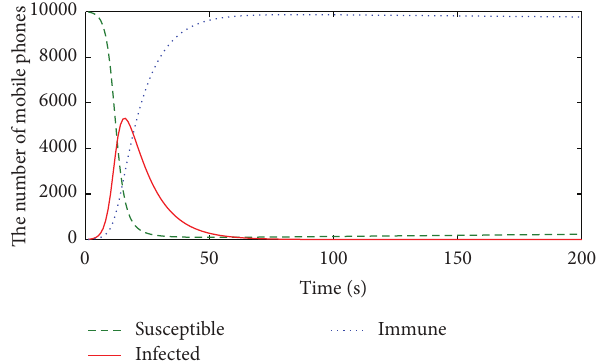
rapid the propagation speed and wide the propagation scope of mobile user-tricking virus.